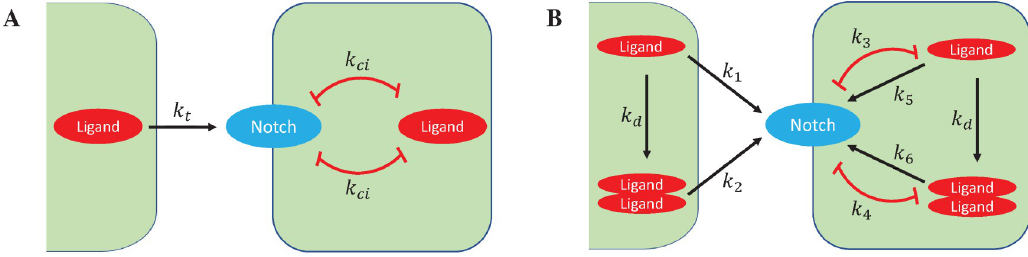
Fig 5. Diagrammatic representation of the mutual inactivation model and the general ligand dimerization model for Notch signalling. Black arrows indicate dimerization of ligand monomers, trans-activation and cis-activation of Notch; Red lines represent cis-inhibition.